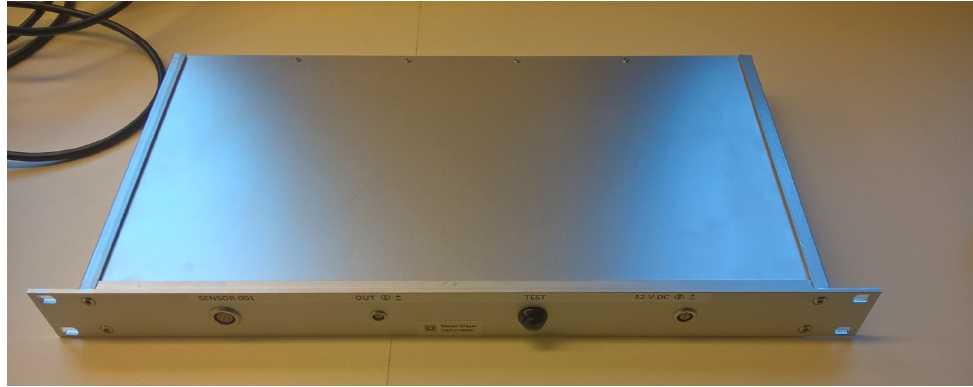
Figure 6. Picture of the enclosure of the front-end electronics